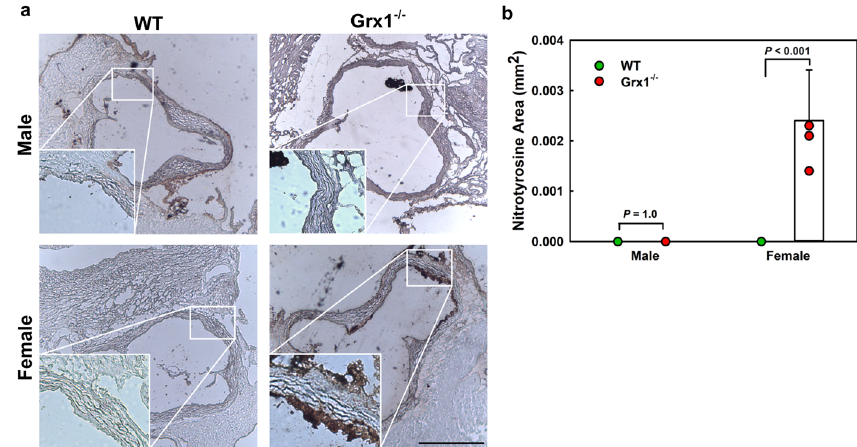
Fig. 6 Hematopoietic Grx1 de fi ciency promotes formation of nitrotyrosine in the aortic root of aged female but not male mice. a Representative images of aorta root sections stained with an antiserum against nitrotyrosine from 18-month-old male and female WT and Grx1 -/- mice maintained on a normal chow diet for 18 months. Scale bar: 500 μ m. Inserts: 100x magni fi cation. b Nitrotyrosine levels measured in the aortic root of male and female WT and Grx1 -/- mice maintained on a normal chow diet for 18 months. All data are expressed as mean ± S.D, n = 5 – 6 per group, 8 aortic root sections per mouse. Source data are provided as a Source Data fi